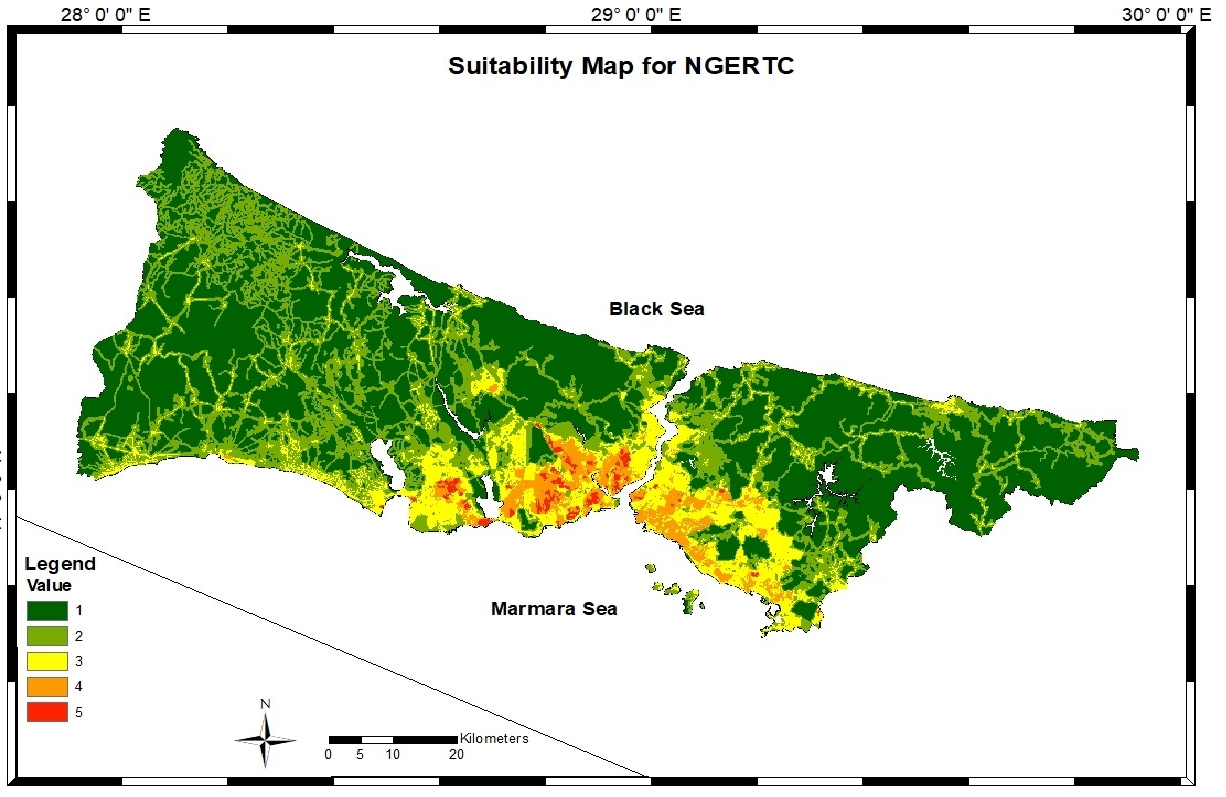
Figure 10. Suitability map for NGERTCs.